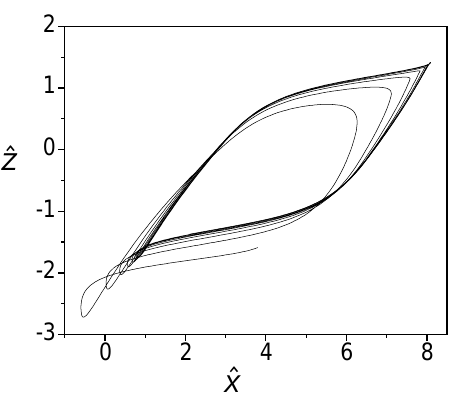
Fig. 6. Hysteresis estimation at adaptation of